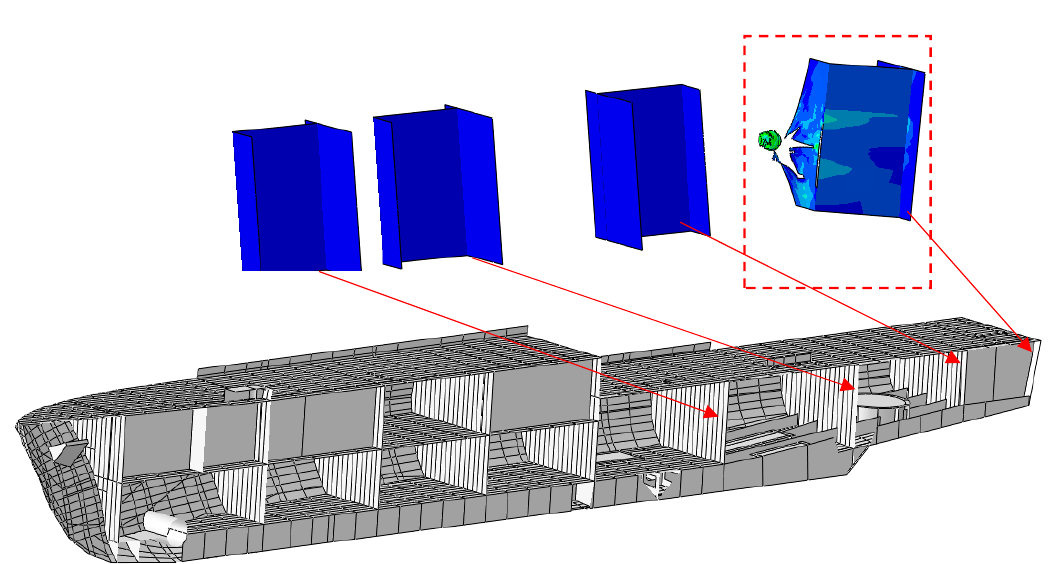
Figure 10. The 3 mm thick hull bullet penetration results.